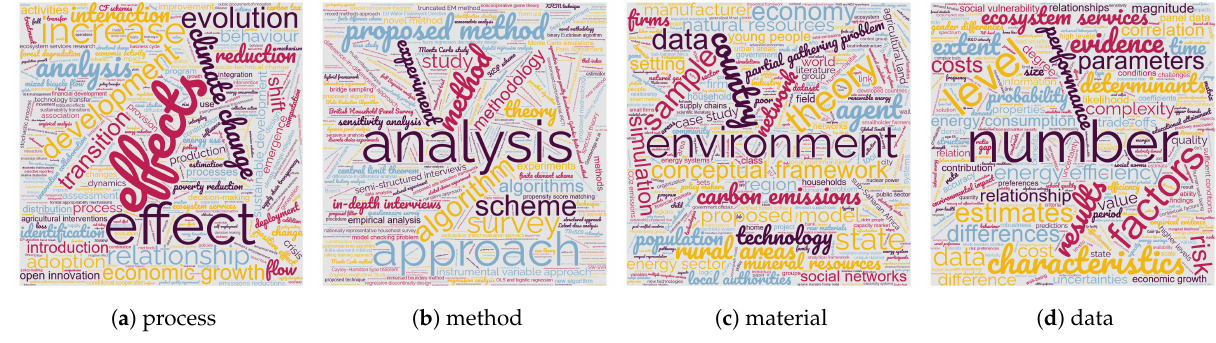
Figure 9. Mathematics domain word clouds.